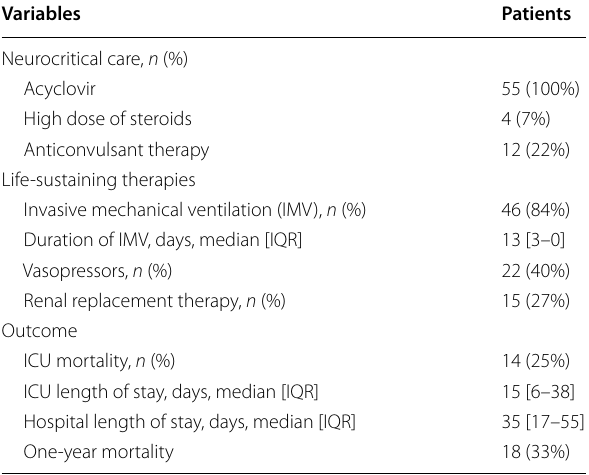
Table 2 ICU management and outcome